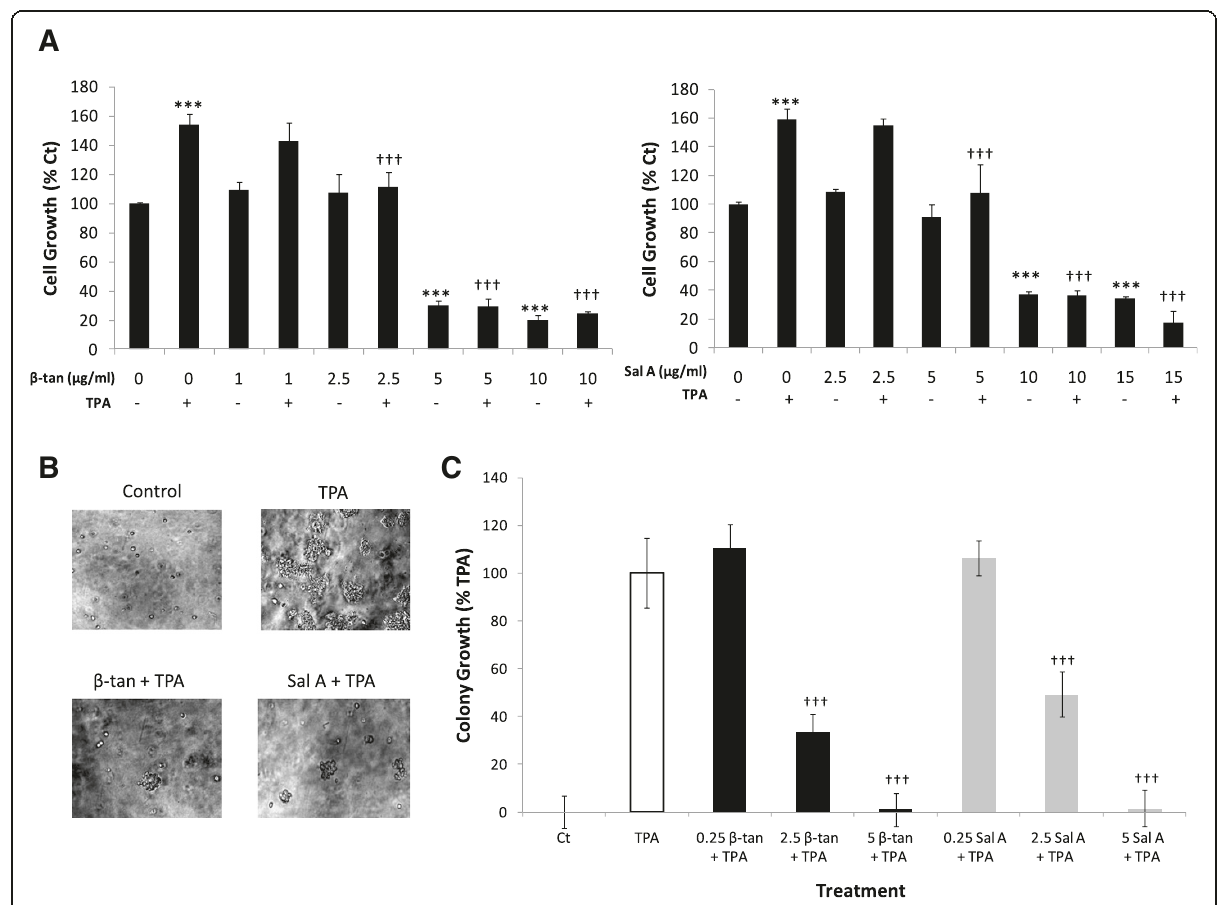
Figure 3 β -tan and Sal A inhibit promoter-induced proliferation and transformation of JB6P+cells. At 50 – 60% confluency, JB6P+cells were treated with the indicated concentrations of β -tan and Sal A, with or without TPA co-treatment. (A) Cell growth was determined at 48 h and expressed as percentage of control (Ct) treated cells using the MTT Cell Proliferation Kit. Significance from TPA treatment is indicated by ††† at p < 0.001 while significance from control treatment is indicated by *** at p < 0.001. Results represent the averages (± SEM) of at least